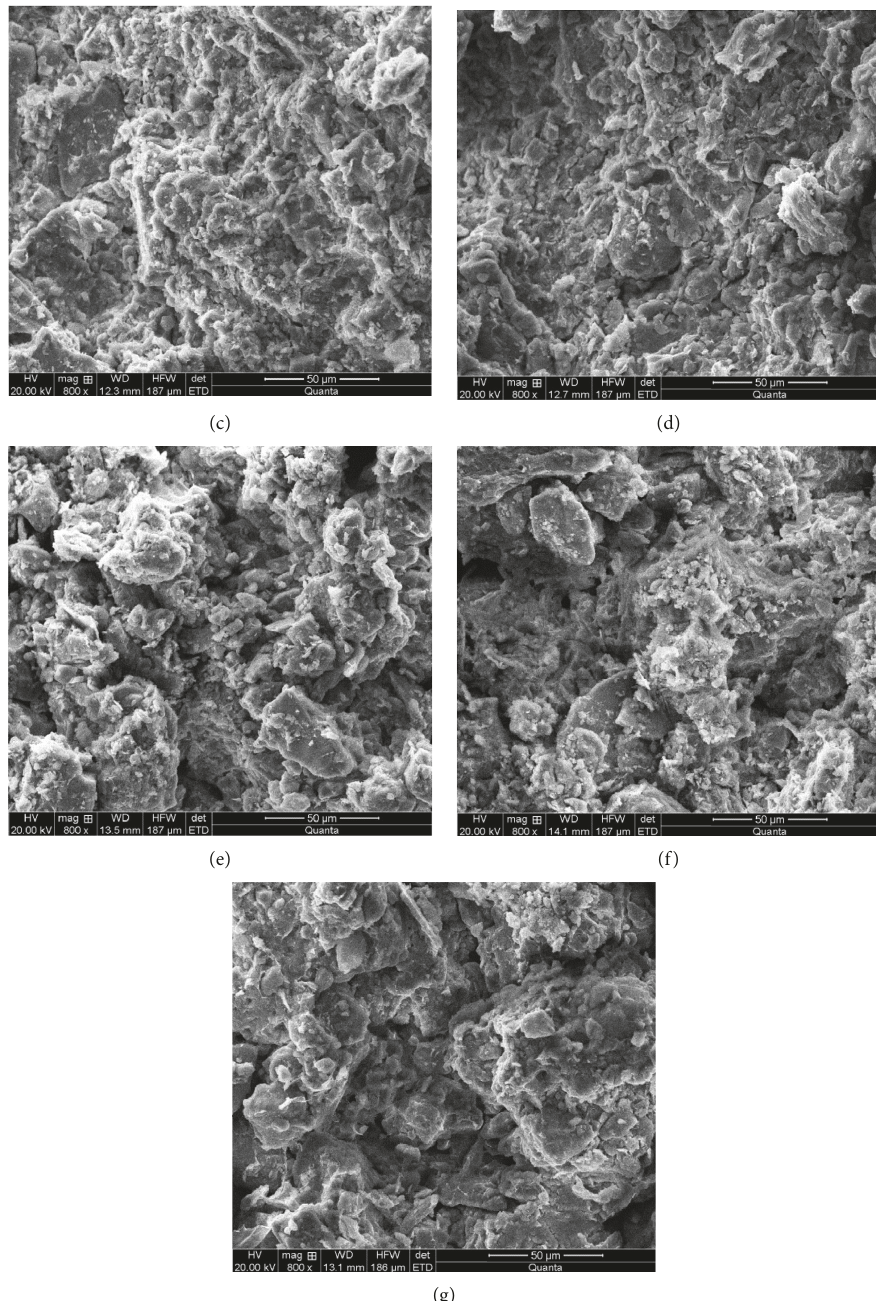
Figure 15: SEM pictures of the sample. (a) Without freezing-thawing cycle. (b) Closed system with 1 cycle. (c) Closed system with 3 cycles. (d) Closed system with 5 cycles. (e) Open system with 1 cycle. (f) Open system with 3 cycles. (g) Open system with 5